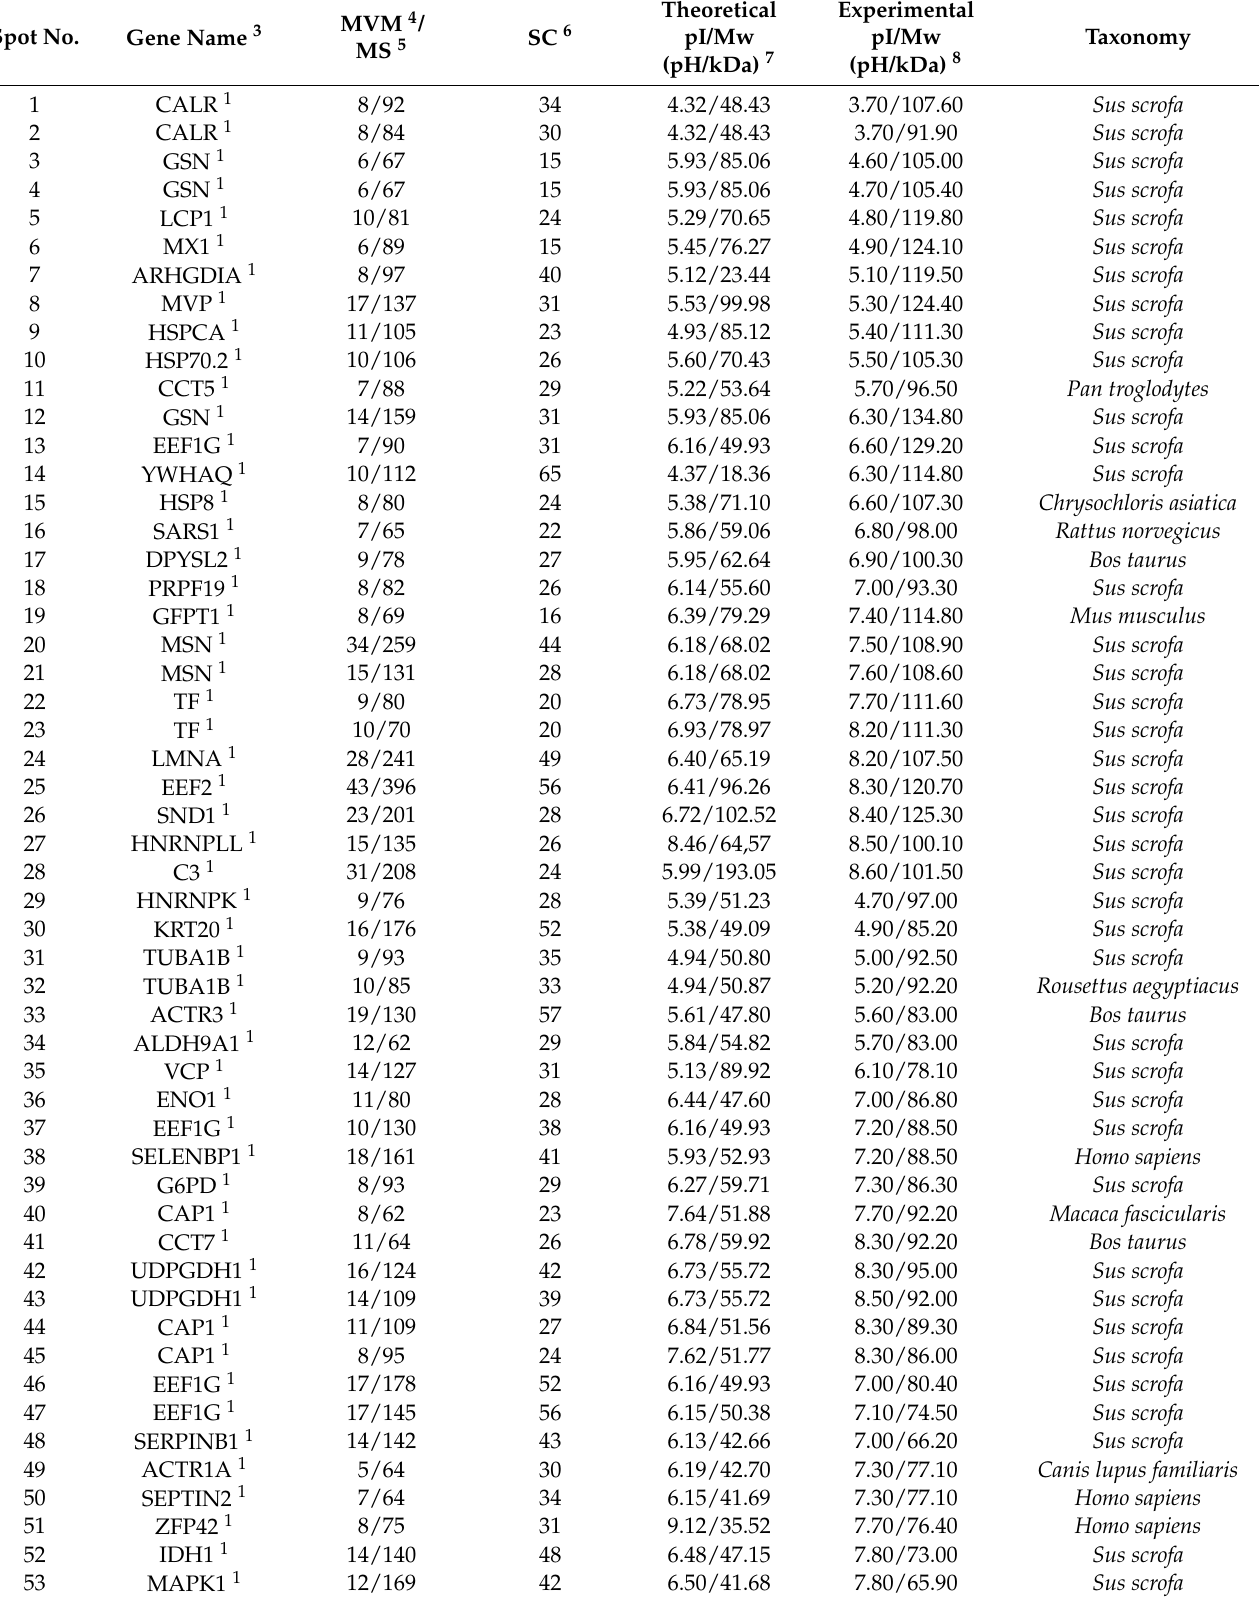
Table 4. List of protein spots identified by MALDI-TOF MS and MALDI FT-ICR MS found in the cecal mucosa of nursery pigs. Spot numbers correspond to those in Figure